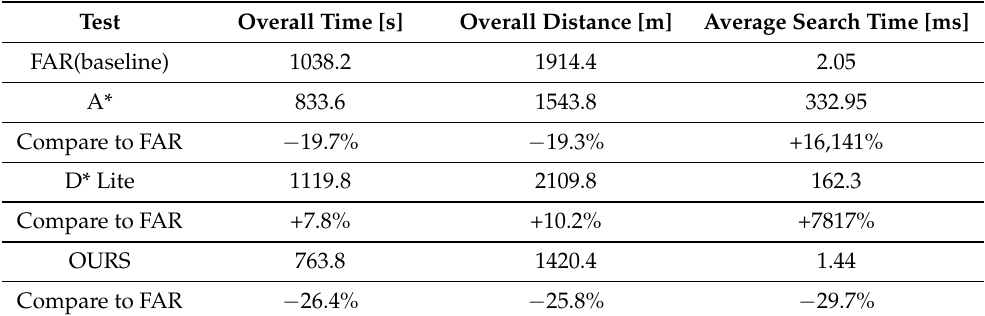
Table 3. The overall time spent by the robot using different algorithms in [s] in Tunnel